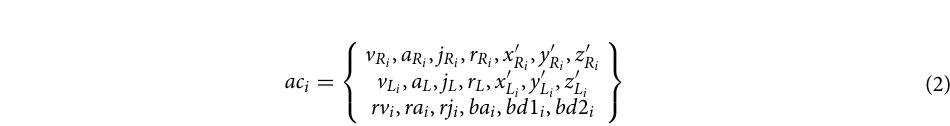
Figure 3. Outline of alignment using DTW. By identifying the optimal path that minimizes the total distance of the Euclidean distance matrix, the two surgical process models can be optimally aligned. DTW dynamic time